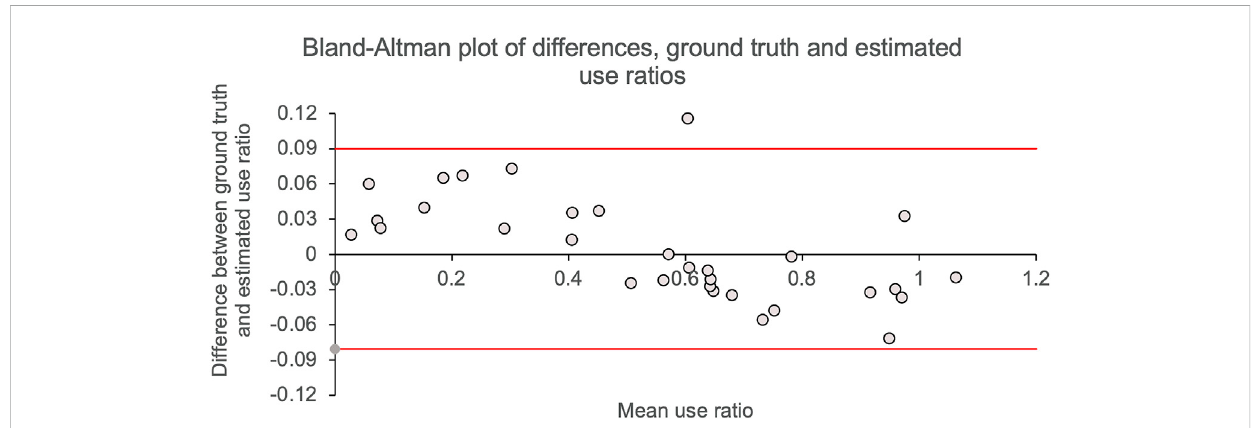
FIGURE 3 Bland – Altman plots. Difference in use ratios calculated using machine learning versus video-labeled accelerometry data are shown on the y -axis. The mean of use ratios calculated using machine learning and video-labeled accelerometry are shown on the x -axis. Solid gray line shows